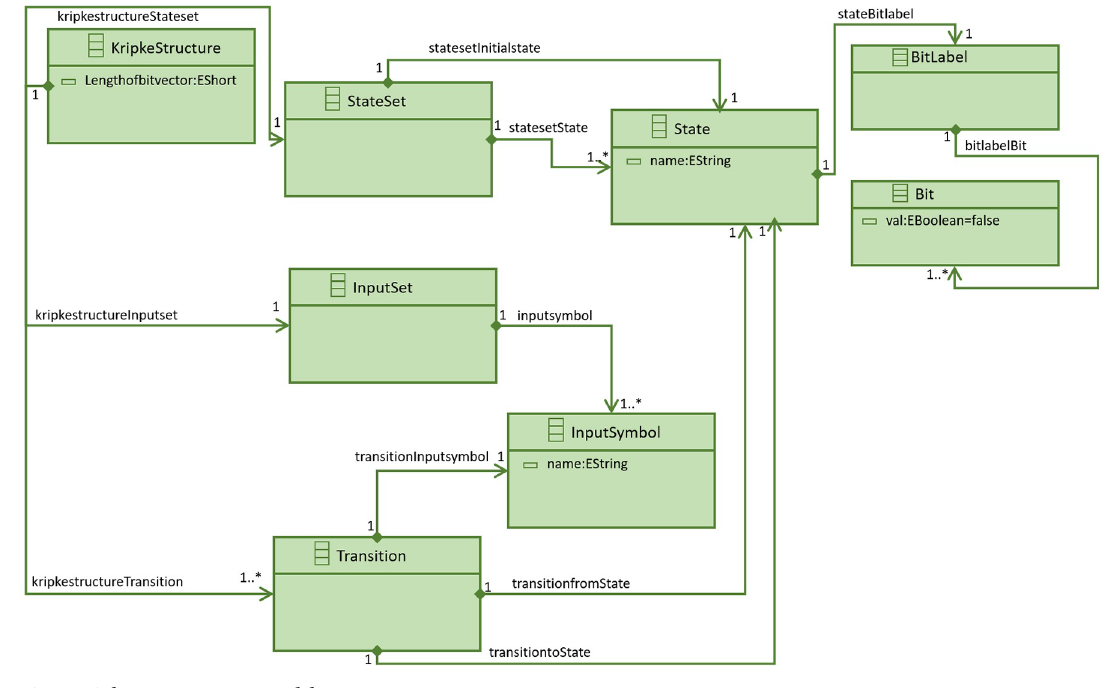
Fig 5. Kripke structure